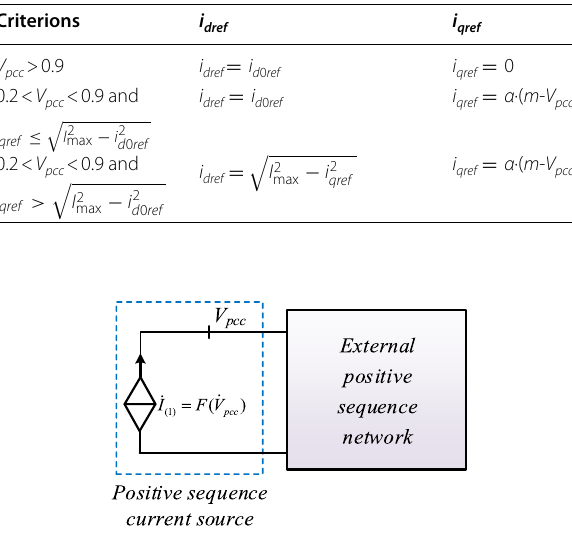
Fig. 2 Positive‑sequence equivalent circuit of the